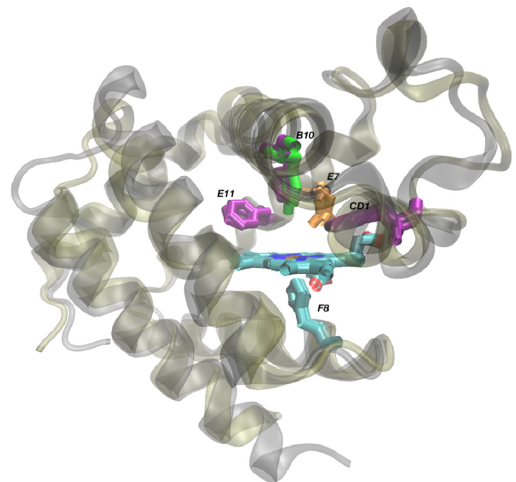
Figure 1. Structural alignment of HbI Lp protein structure (PDB 1FLP) and HbII Lp (PDB 2OLP) showing their amino acid distribution in the heme pocket. Alignment was done using the STAMP algorithm as implemented in MultiSeq in VMD. The only difference between the two heme pockets is the amino acid in position B10, a phenylalanine for HbI Lp and a tyrosine for HbII Lp . Both hemoglobins have a phenylalanine at positions CD1 and E11, a glutamine at position E7 and a histidine at position F8. HbII Lp and HbIII Lp have the same heme pocket amino acid distribution. The RMSD for the backbones (residues 2–147) is 6.54